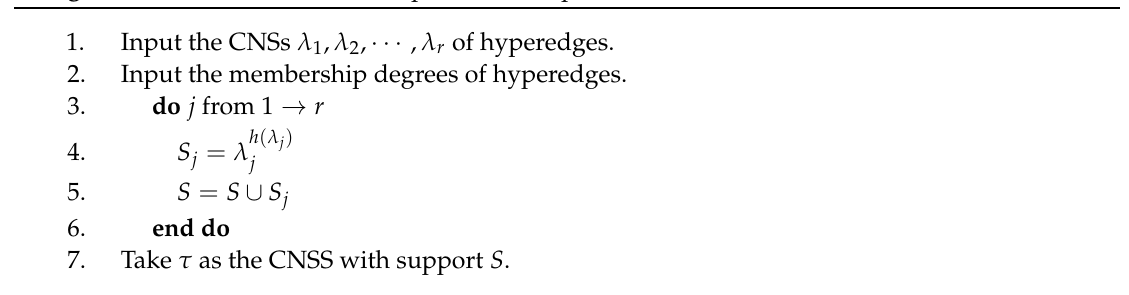
Algorithm 2: Find a minimal complex neutrosophic